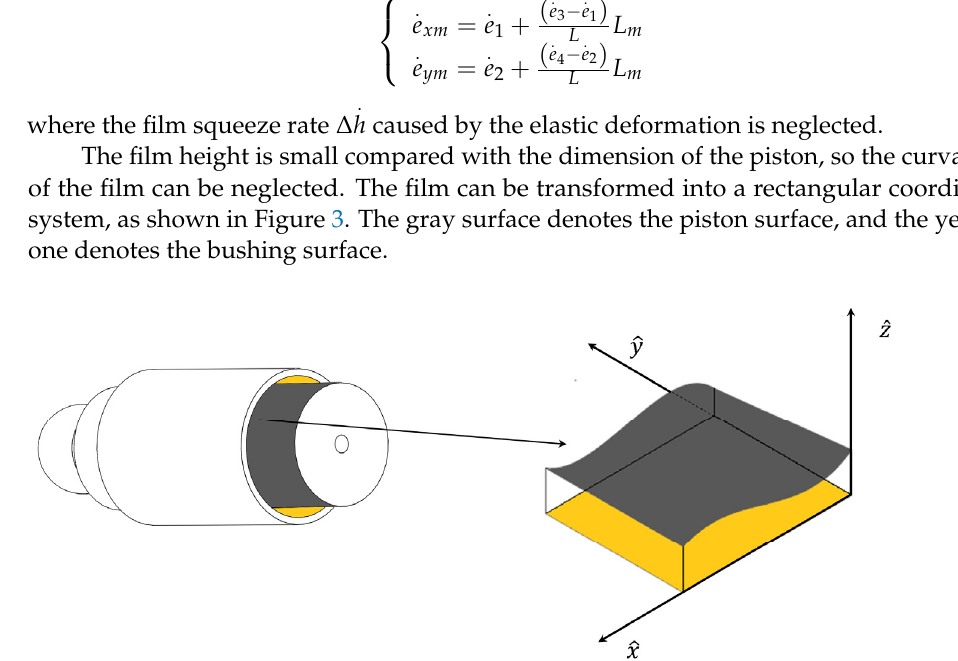
Figure 3. The fluid film in a rectangular coordinate system